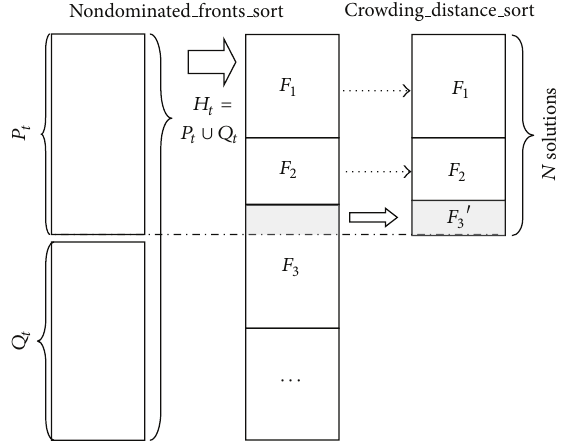
Figure 4: Procedures of generating new population 𝑃 𝑡+1 from 𝑃 𝑡 and 𝑃 𝑄 𝑡 , where 𝑡 is the parent population and